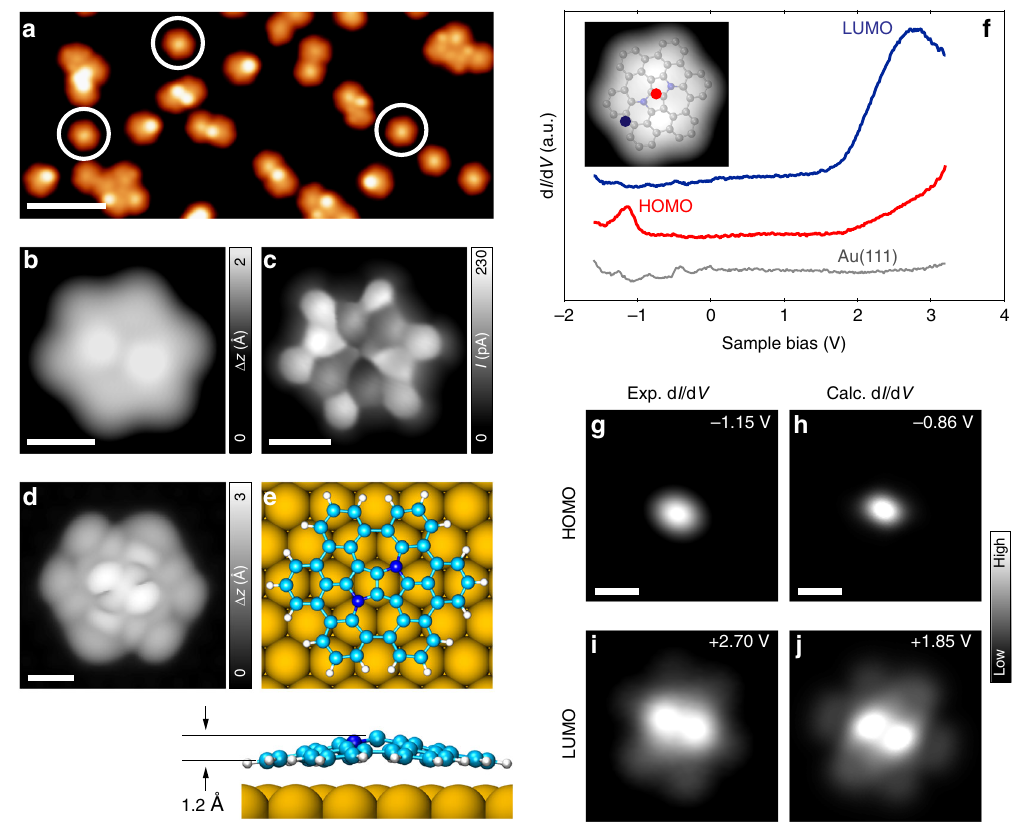
Fig. 4 Structural and electronic properties of the nitrogen-embedded buckybowl 8 . a Overview STM topography image of the surface after an annealing step to 320 °C, showing the presence of mostly half-closed species ( 7b ), and the fully closed buckybowls ( 8 ) highlighted by the white circles ( V = − 1.2 V, I = 20 pA, scale bar: 5 nm). b High-resolution STM image of 8 acquired with a CO tip ( V = − 0.1 V, I = 50 pA, scale bar: 0.5 nm). c Corresponding UHR-STM image of 8 , evidencing complete ring closure and presence of the ISTW topology at the core (open feedback parameters: V = 5 mV, I = 50 pA; Δ z = − 50 pm; scale bar: 0.5 nm). d DFT-simulated STM image of 8 ( V = − 0.3 V, scale bar: 0.5 nm). e Top (upper panel) and side (lower panel) views of the DFT equilibrium geometry of 8 . The out-of-plane buckling of the buckybowl to assume the bowl-opening-down conformation is evident. f STS spectra on 8 showing differential conductance peaks at − 1.15 V and + 2.70 V corresponding to the highest occupied molecular orbital (HOMO) and the lowest unoccupied molecular orbital (LUMO). A reference spectrum on Au(111) is shown in gray and serves as marker for the tip quality. The spectra are vertically shifted for clarity. Inset: STM topography image of 8 with overlaid DFT-optimized molecular model. The red and blue circles mark the positions at which the corresponding STS spectra were acquired. g , i Experimental d I /d V maps at the energies of HOMO and LUMO; and h , j corresponding DFT-simulated d I /d V maps at a tip-sample distance of 5 Å. (Open feedback parameters for the STS spectra: V = − 1.6 V, I = 50 pA, V rms = 20 mV, f = 860 Hz. Open feedback parameters for the experimental d I /d V maps: d V = − 1.15 V, I = 40 pA, V rms = 20 mV, f = 860 Hz; i V = 2.70 V, I = 40 pA, V rms = 20 mV, f = 860 Hz.) All scale bars: 0.5